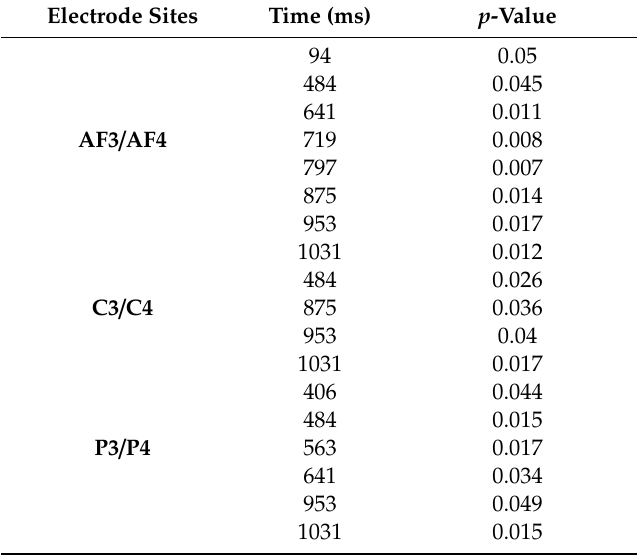
Table 3. Summary of significant ERP results for group by emotion across all significant time periods for pleasant versus violent emotion